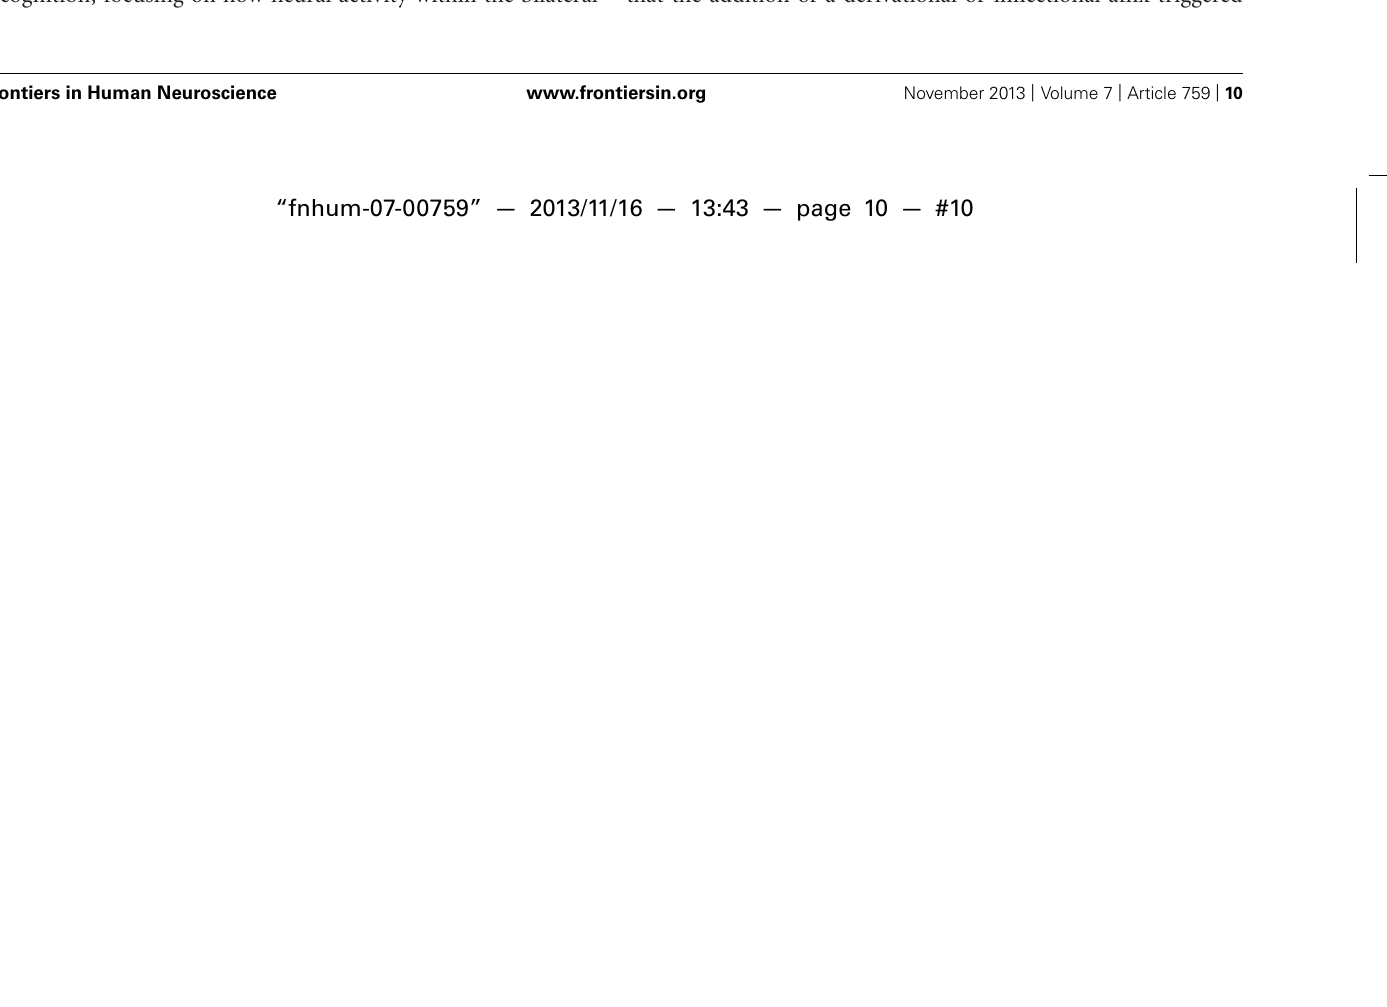
to 270 ms, there was no main effect of condition ( F ( 1,14 ) = 2.05, p > 0.05), but a significant effect of ROI ( F ( 4,56 ) = 3.30, p < 0.05), and a significant condition by ROI interaction ( F ( 4,56 ) =